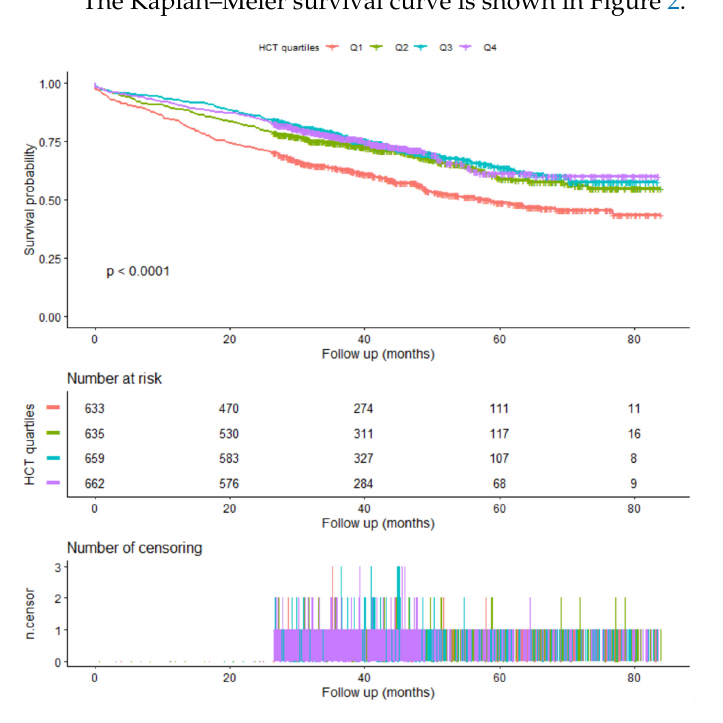
Figure 2. Kaplan ‐ Meier survival. Figure 2. Kaplan-Meier